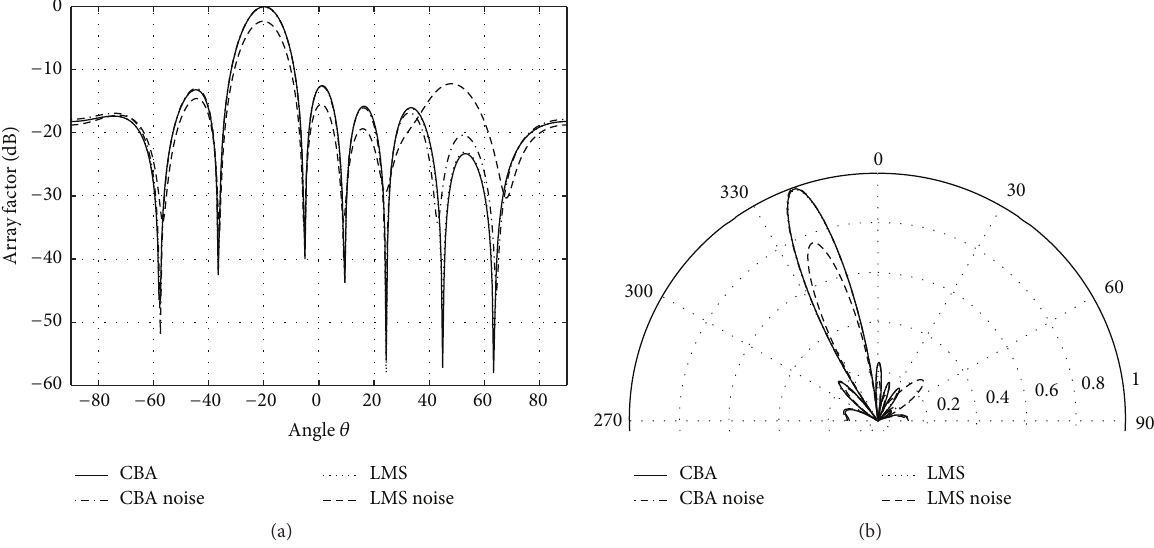
Figure 5: Comparison of the normalized radiation patterns obtained by the Chaotic beamforming algorithm and the LMS algorithm: the angle of arrival of the desired signal is − 20 ∘ and the angle of arrival of the interfering signal is 45 ∘ , (a) in the ( 𝑥 - 𝑧 ) plane and (b) in polar coordinates.